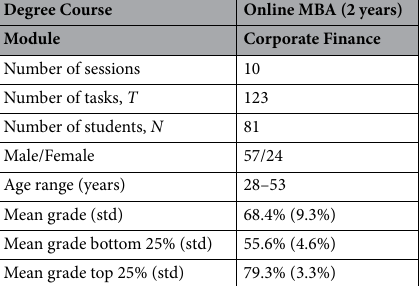
Table 1. Information about course and summary statistics for the dataset used in this paper.